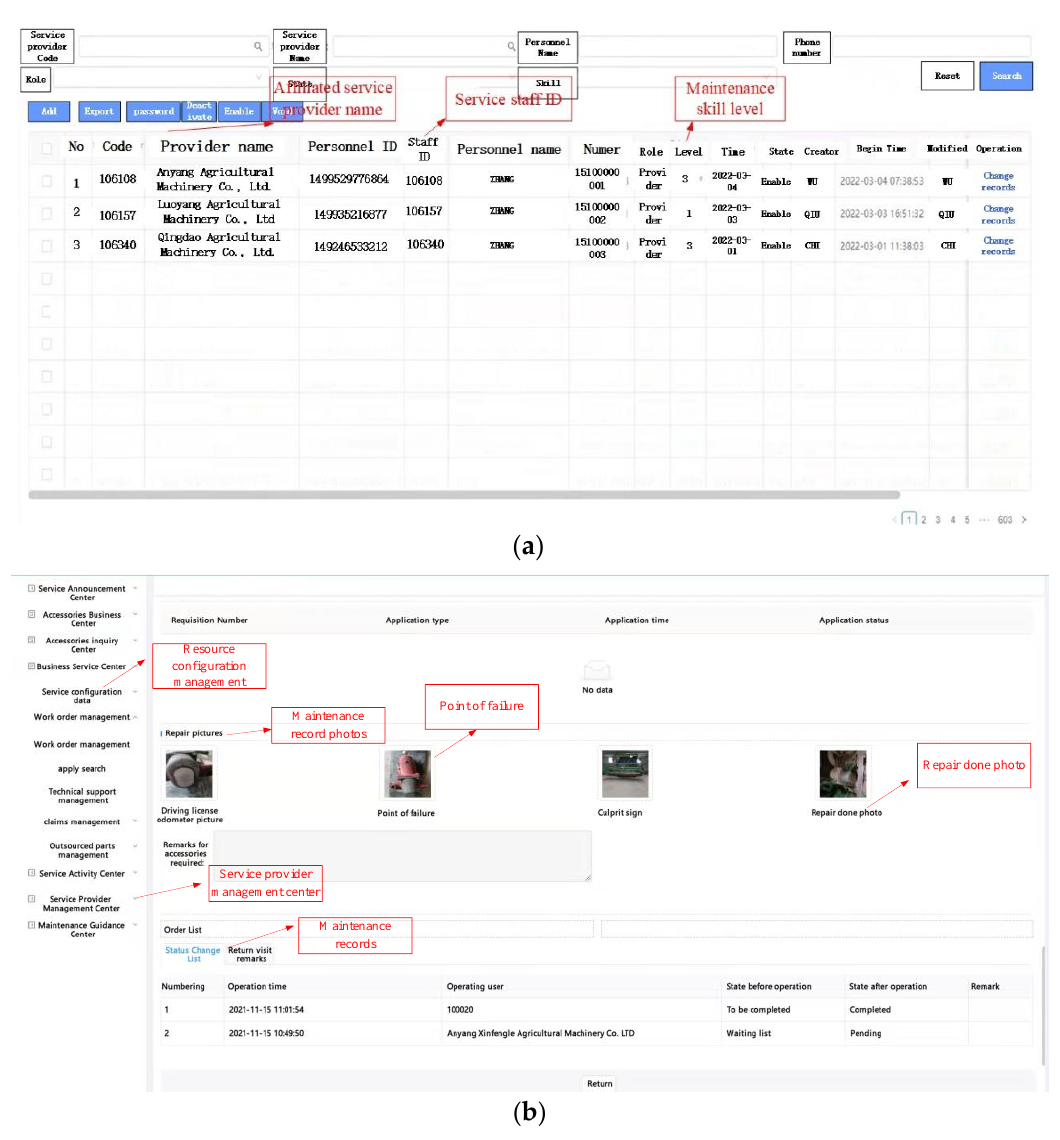
Figure 7. Operation and maintenance platform information management system. ( a ) Maintenance personnel information management; ( b ) Order History Repair Record Details.